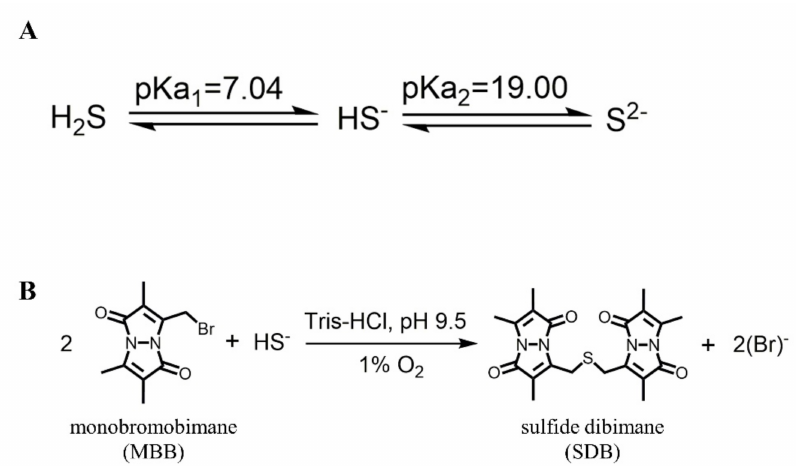
Figure 2. The mechanism for the detection of H 2 S. ( A ) The acid dissociation constant of H 2 S; ( B ) the mechanism of monobromobimane (MBB) reaction with HS − to produce SDB in an alkaline and hypoxia